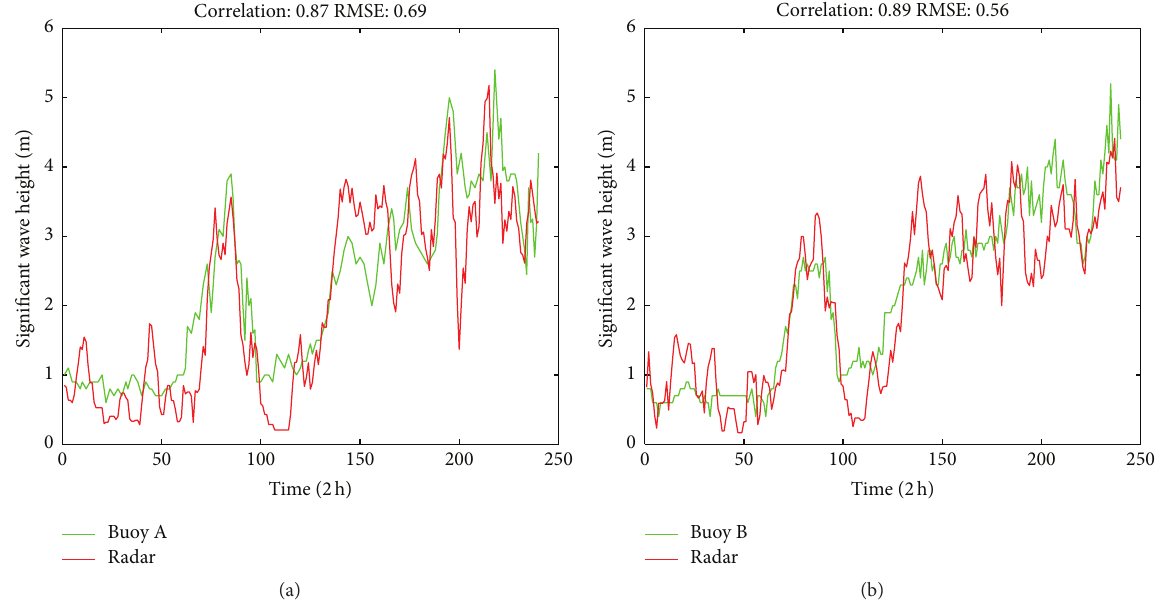
Figure 4: The local wave measurements between radar and buoys, time relative to 10:00 Sep 25, 2014. (a) Buoy A; (b) Buoy B.